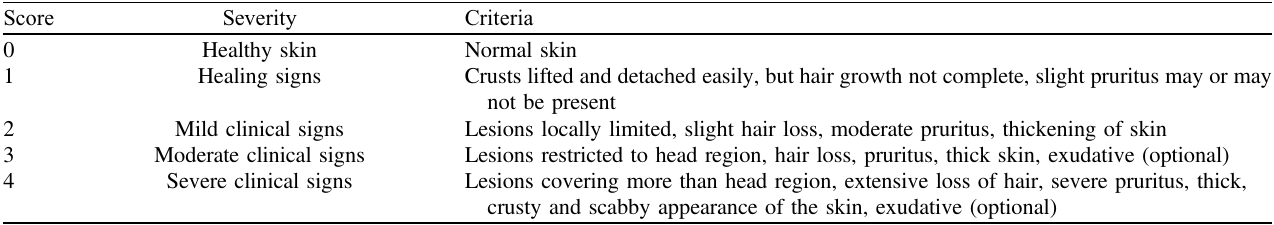
Table 1. Clinical mange scores a